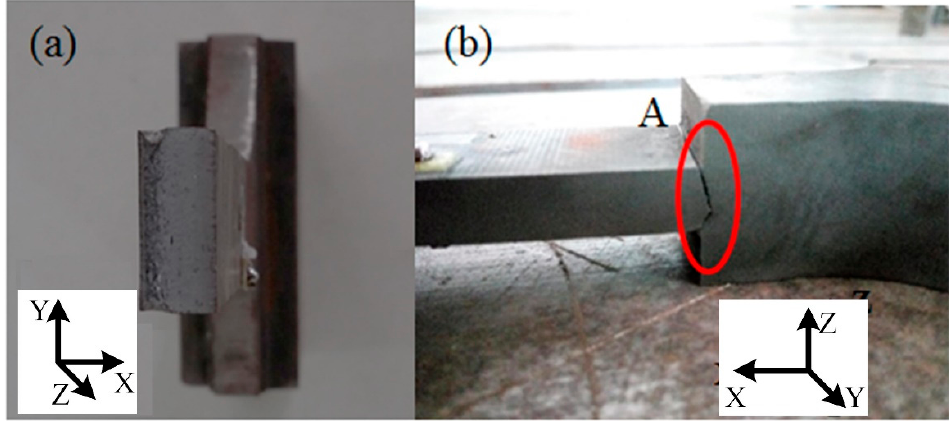
Figure 6. The fracture surface of designed T- type specimen ( a ), the crack growth path ( b ).